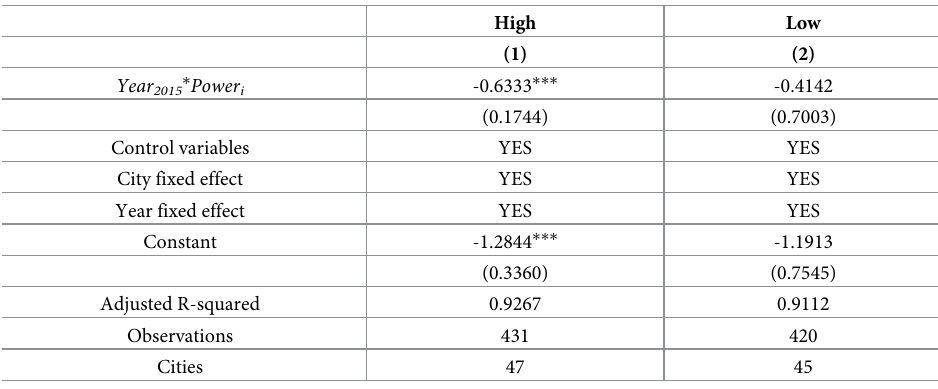
Table 12. Heterogeneity of air pollution